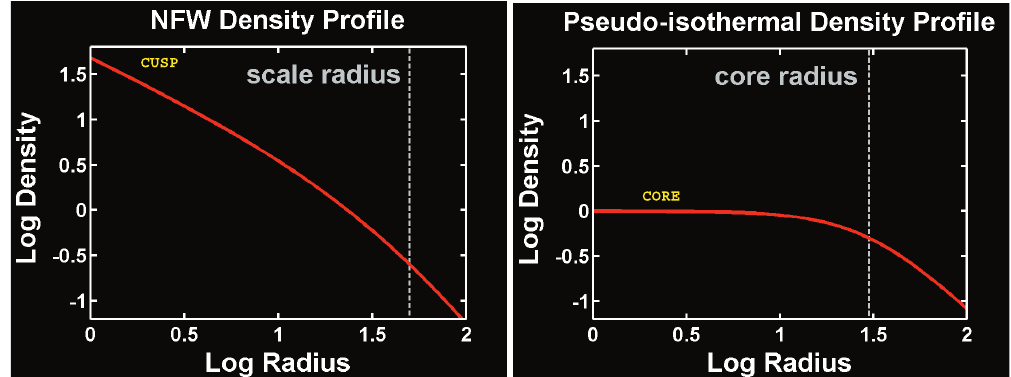
Figure 1. Schematic representation of the CC problem. The left panel represents the cuspy NFW profile. The dotted vertical line is the scale radius of the profile. The right panel represents the case of a cored profile. The dotted vertical line is the core radius of the profile.